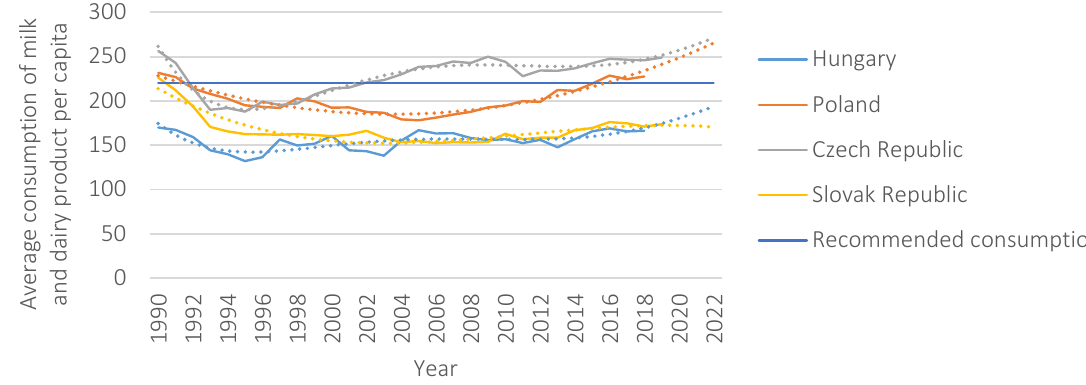
Figure 1. Comparison of the average total consumption of milk and dairy products in the Slovak